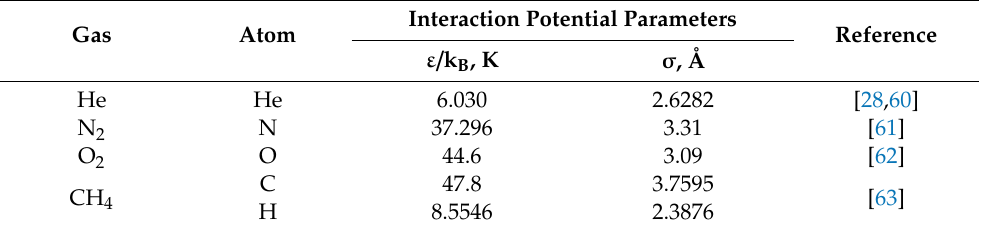
Table 2. Parameters for van der Waals and electrostatic interactions of atoms of the studied